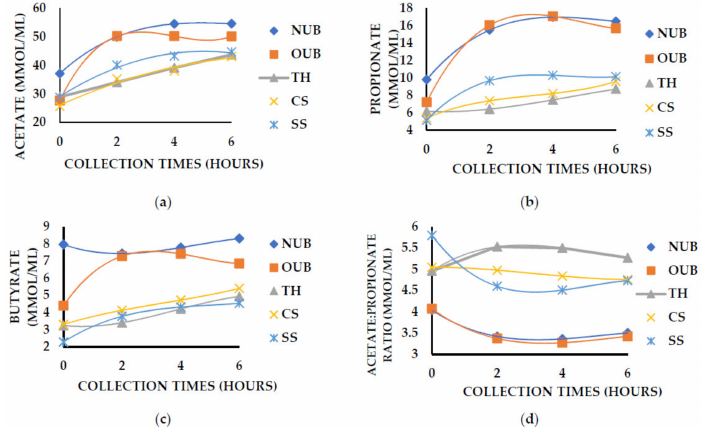
Figure 2. Effect of roughage × collection time interaction ( p < 0.01) on ruminal concentration ( µ Mol/mL) of acetate ( a ), propionate ( b ), and butyrate ( c ) and acetate:propionate ( d )